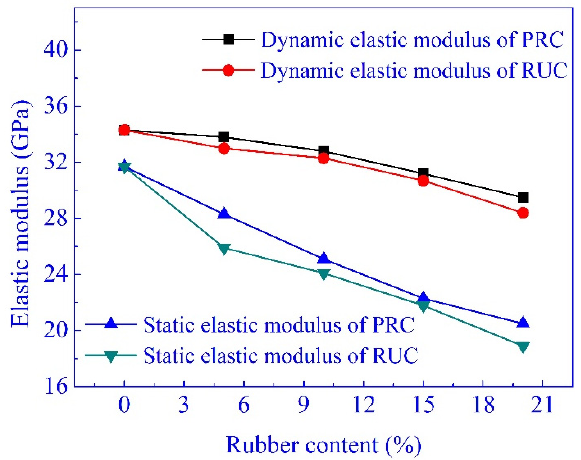
Figure 8. The dynamic and static elastic modulus.